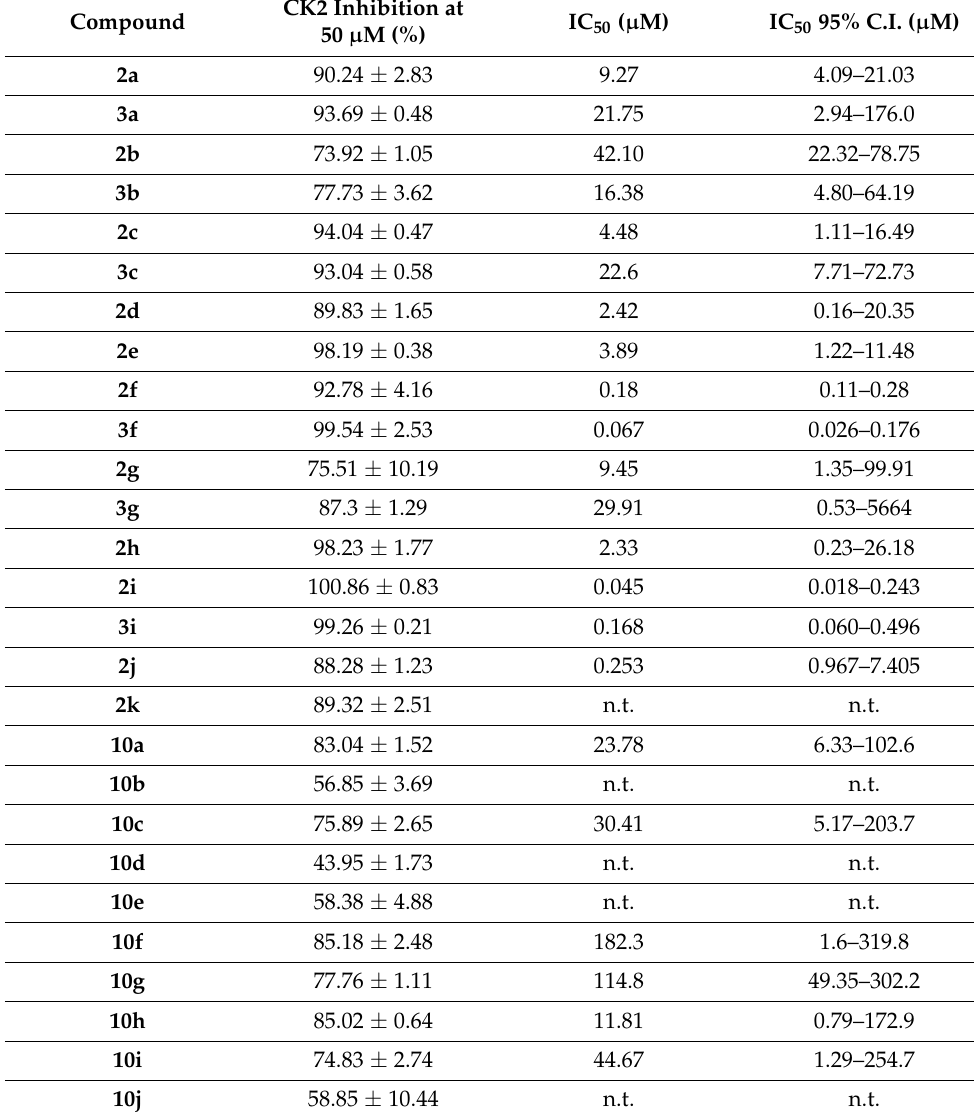
Table 2. CK2 inhibition of obtained tetrazolyl-azolopyrimidines 2,3 and their sodium salts 10 , 11